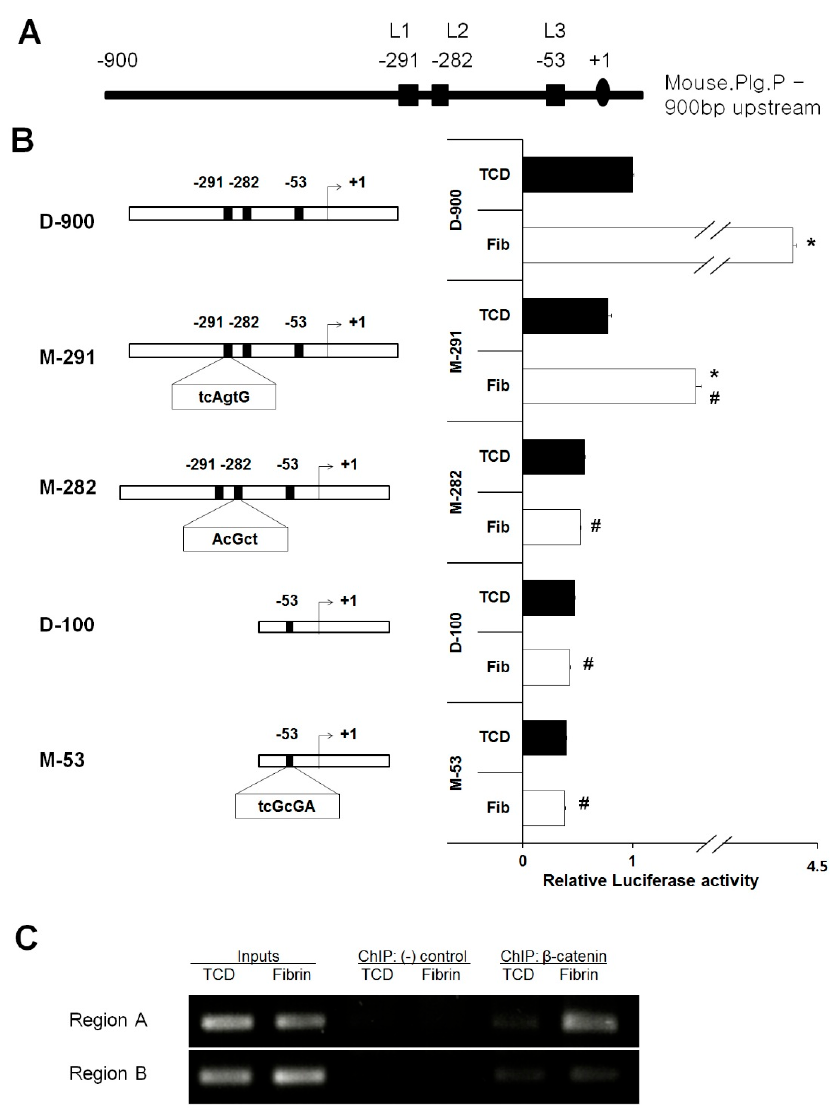
Figure 6. Plasminogen is a direct target of the canonical Wnt signaling in the OCCM30-fibrin. There are three putative response elements for the nuclear mediator of Wnt signaling LEF1 in the mouse plasminogen proximal promoter regions ( − 900 to +54). The binding positions are shown ( A ). Transient transfection was performed with luciferase reporter constructs containing the plasminogen promoter regions wild type (D-900 and a deletion construct D-100), mutants (M-291, M-282, and M-53), and an empty basic plasmid pGL-3 as a control. Firefly luciferase activities were quantified and normalized with the Renilla luciferase activities ( B ). Chromatin immunoprecipitation assay was performed to confirm the binding of β -Catenin to the LEF1 putative binding sites (Region A: L1 & L2; Region C: L3) on the plasminogen promoter ( C ). Each experiment was repeated two times independently. * Significantly different from the OCCM30-TCD groups ( p < 0.05), # significantly different form from D-900 in the OCCM30-fibrin group ( p < 0.05).